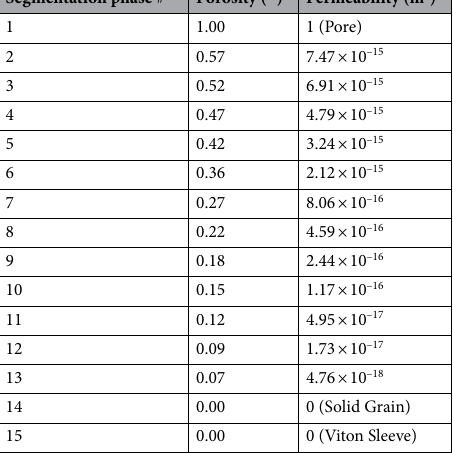
Table 1. Porosity and permeability values for micro-porosity used in the DBS simulations taken from Menke et al. 32 .